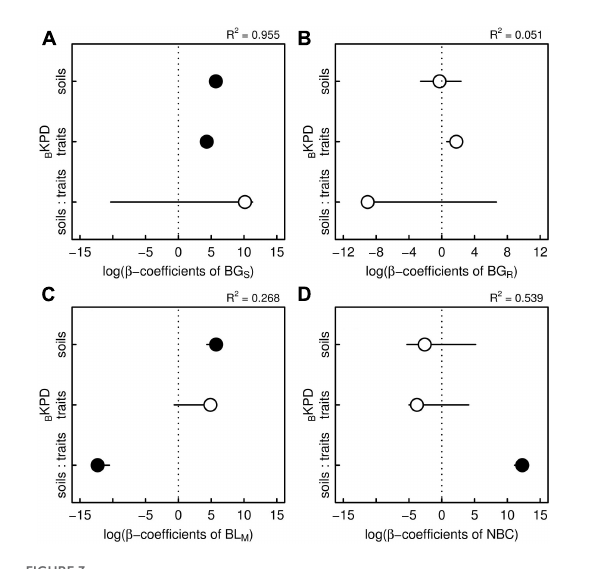
FIGURE3 β -coefficients of the generalized linear models (GLM) showing the effects of bivariate kernel probability densities of species biomass stocks ( B KPD) based on soil resources (soils), functional traits (traits), and their interaction (soils: traits) on each component of biomass productivity: (A) biomass gained by surviving trees (BG S ), (B) biomass gained by recruited trees (BG R ), (C) biomass lost by tree mortality (BL M ) and (D) net biomass changes (NBC) in t ha − 1 yr − 1 . Significant (closed points) and non-significant (open points) coefficients are shown under a significance level of